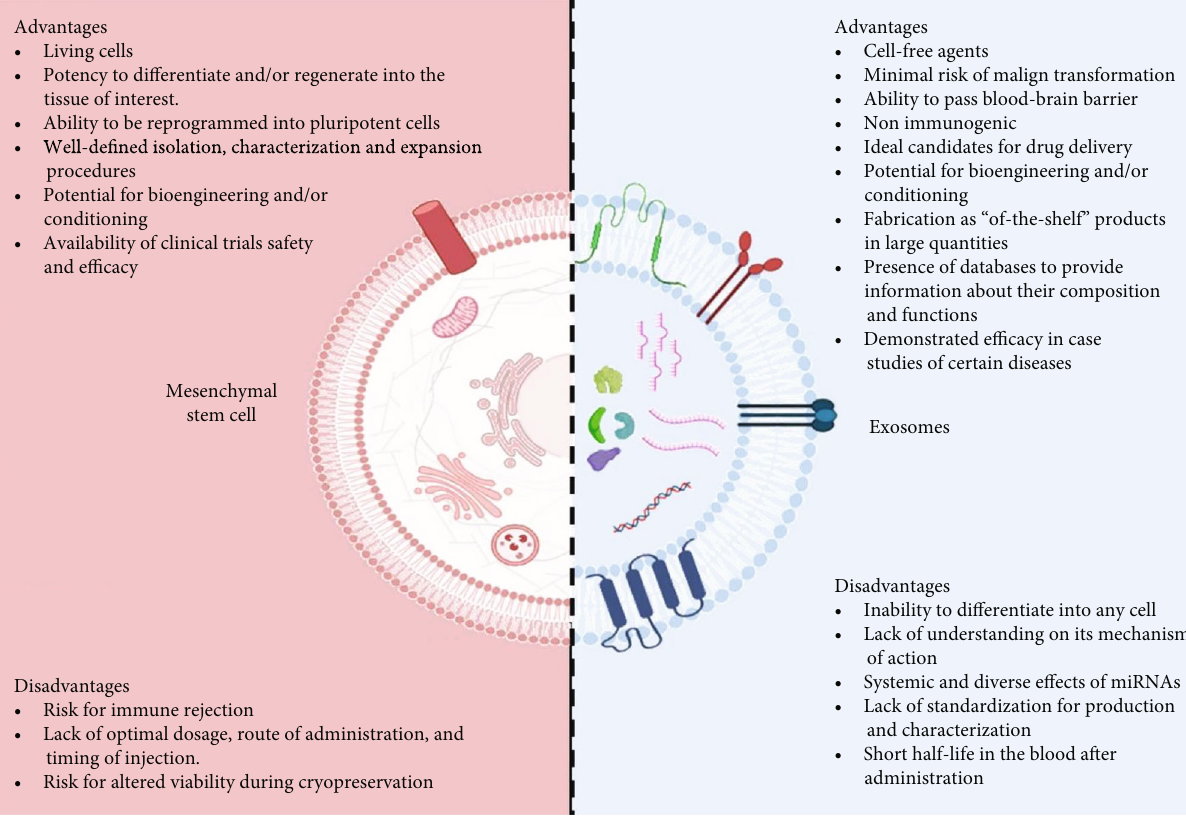
Figure 5: Advantages and disadvantages of MSCs and MSC-derived exosomes (created with